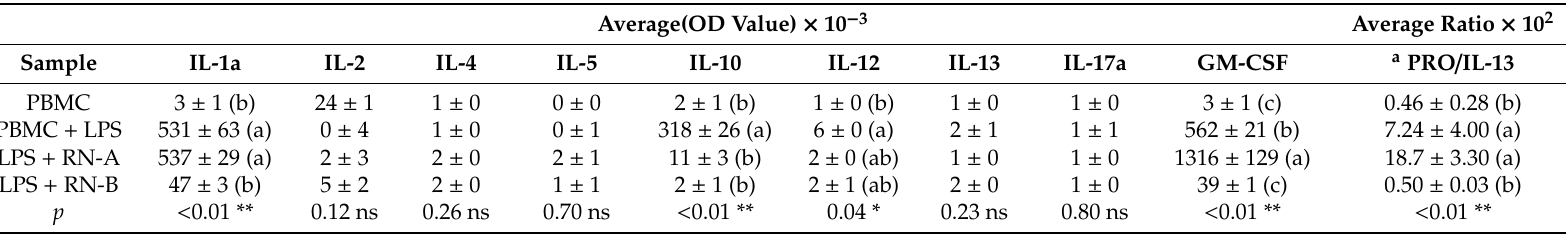
Table 6. PBMC cytokines expression in presence of C-GMs and the pro-inflammatory stimulus, and the ratio between the pro-inflammatory cytokines and